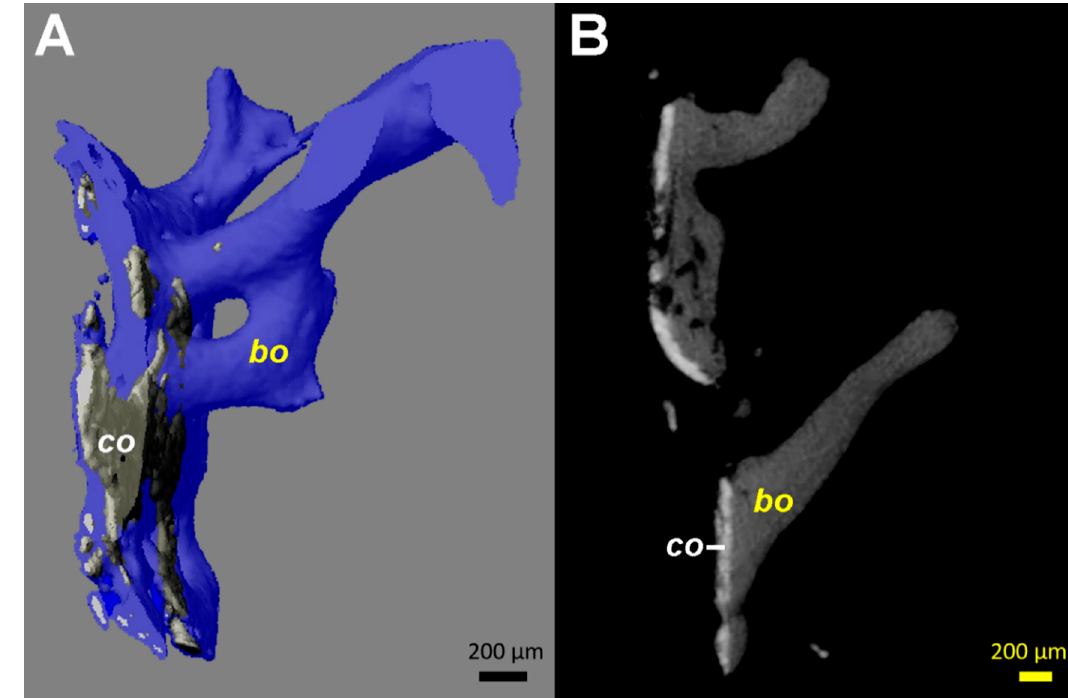
Figure 4. Computed tomography ( μ CT) images from the tissue samples collected at the interface between the stem and the medial cortical bone (area marked by arrowheads in Figure 1C). Identical patterns could be identified on all fragments available, even if the images from only one are illustrated. ( A ) 3D reconstruction in semi-transparent mode shows the close contact of the coating material (co, colored in grey) with bone (colored in blue). The coating ca has a higher density (brighter appearance) than bone (bo). ( B ) 2D transverse reconstruction with section thickness of 10 µ m, showing bone ongrowth on the coating material, without an ingrowth or growth of bone structures through the layer of the coating. All coating fragments were oriented in one plane and were 60–100 µ m thick. Additionally, some small and globular fragments of the HA coating (size < 20 µ m) are identifiable.